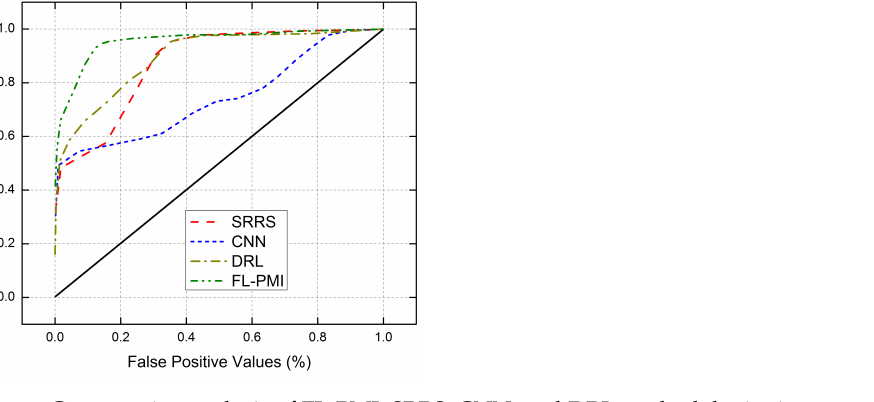
Figure 6. Comparative analysis of FL-PMI, SRRS, CNN, and DRL methodologies in terms of true positive and false positive values.